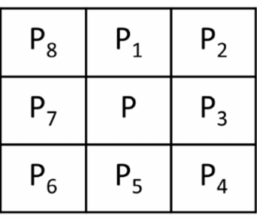
Figure 5. 8-Neighbors of a pixel